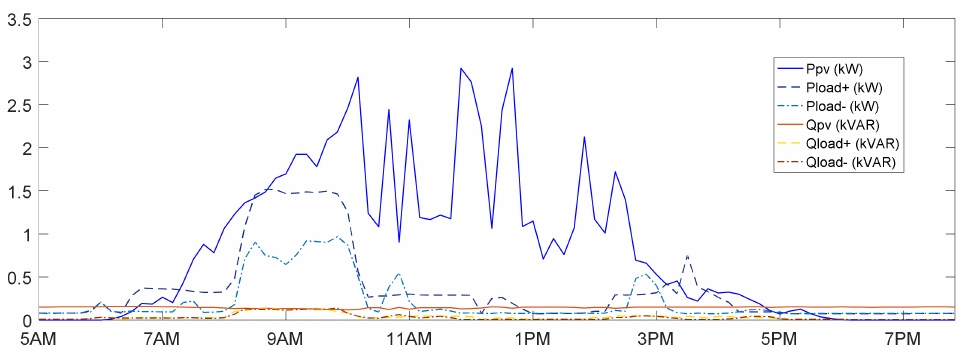
Figure 5. Power behaviour of Phase A.